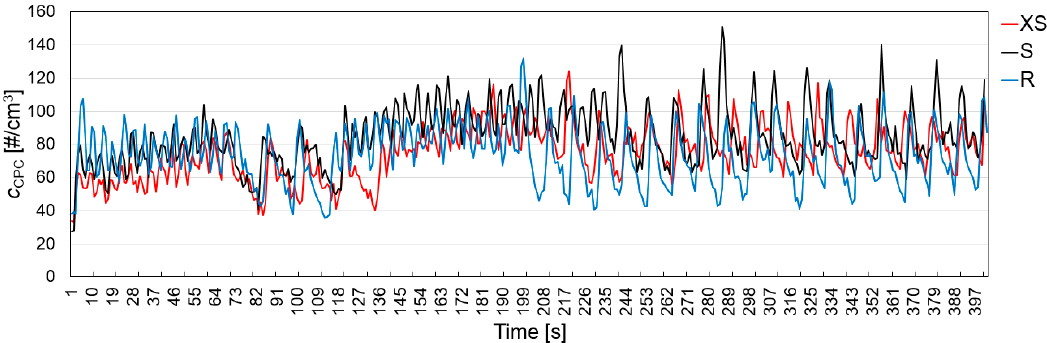
Figure 11. Particle concentration as measured by the CPC during the first 400 s of the dyno bench tests for the three tested surfaces. Rectified (R), scorched (S) and extra-scorched (XS).